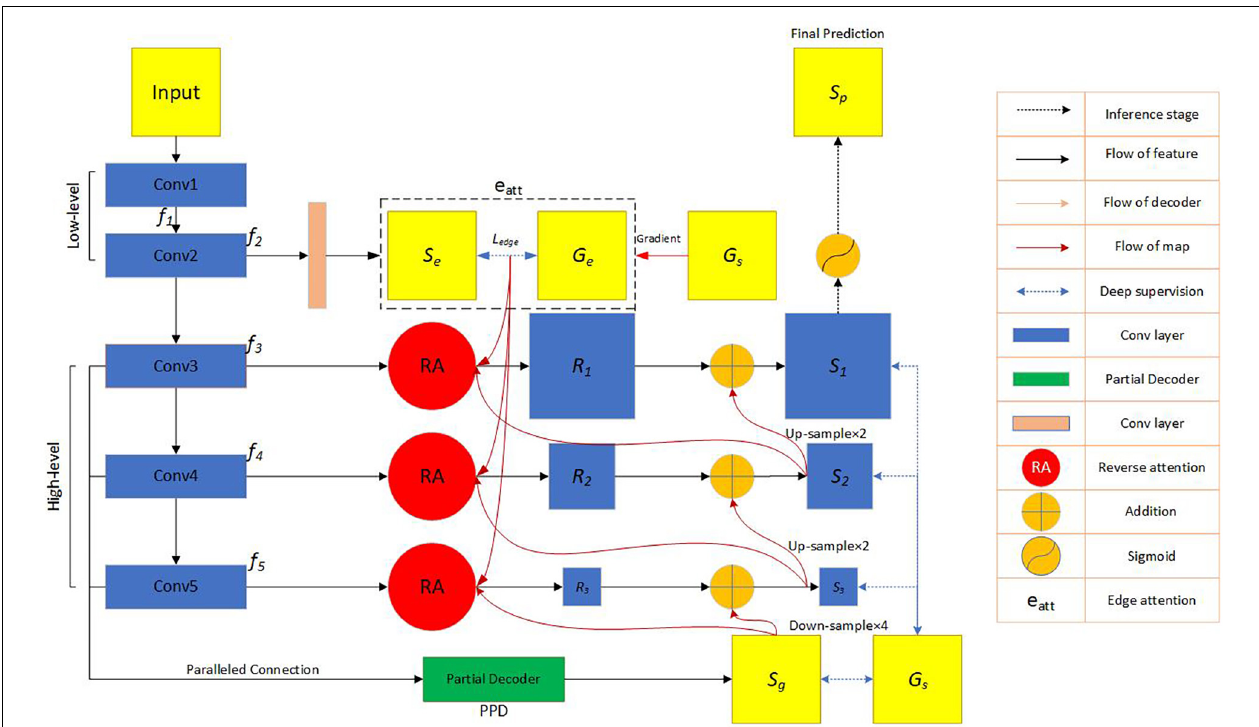
FIGURE 4 | Flow chart of the automatic network segmentation: In the convolutional feature extraction stage, three pre-training models of VGG, ResNet and Res2Net are used, respectively, and the edge attention module, parallel partial decoder module and reverse attention module are added to enhance the feature expression ability. The model also improves the loss function. f i represents the feature information obtained by the image through the i -th convolutional layer. S e represents the feature information generated by the second convolutional layer information through the edge attention module. G e represents the edge map obtained by the ground truth map. L edge represents the standard binary cross-entropy loss function. G s represents the ground truth map. S g represents the feature information obtained by the parallel partial decoder aggregating high-level convolutional layer information. R i ( i = 1 , 2 , 3 ) , respectively, represent the feature information output by the three reverse attention modules. S i ( i = 1 , 2 , 3 ) , respectively, represent the information obtained by the combination of the reverse attention module information and the higher-level